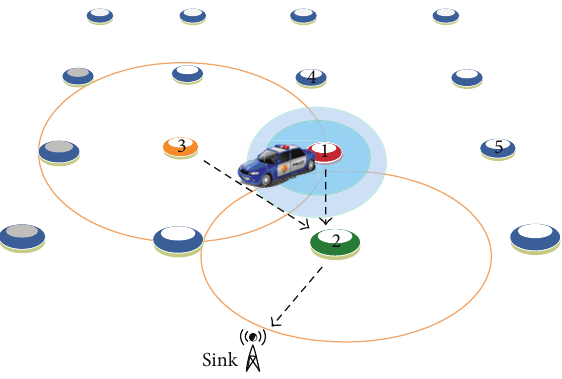
Figure 1: The dynamic power-level sensing